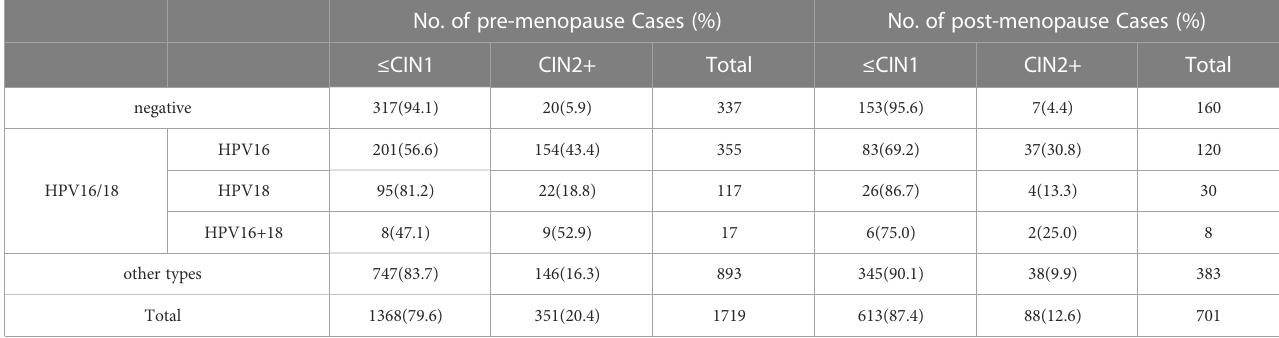
TABLE 5 Histopathologic results for pre- and post-menopausal women with ASC-US according to HPV genotyping. No. of pre-menopause Cases (%)